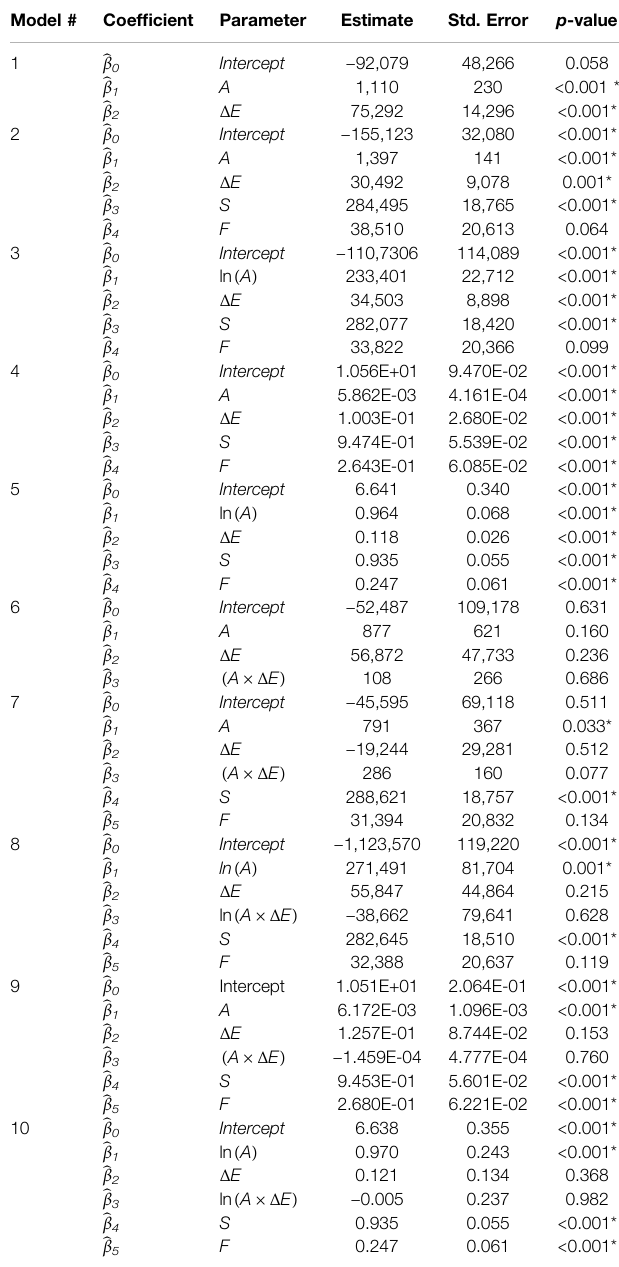
TABLE4| Parameterestimate,standarderror,and p -valueformultipleregression